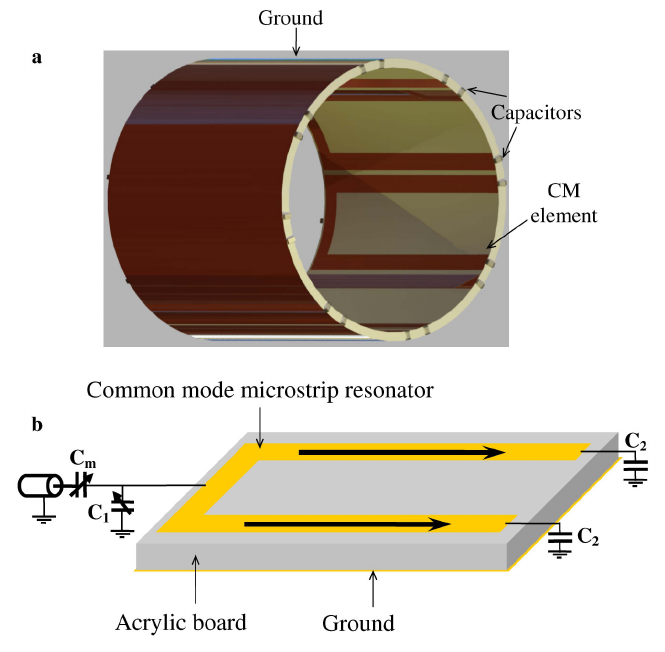
Figure 1. ( a ) Diagram of the 16-strut common-mode microstrip volume coil; ( b ) Diagram of the common-mode microstrip surface coil, where the solid line denotes the common-mode current in the microstrip